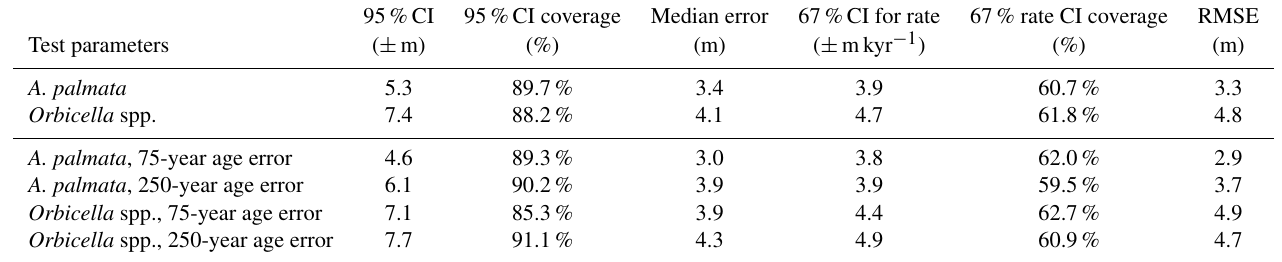
Table D4. Summary of validation test results for the Gaussian model, which are compared to the nonparametric model results (Table D6, select test parameters) with same exact data for sea-level scenario 2 (SL2) to determine the portion of improvement due to the empirical distributions versus due to the inclusion of more data in the nonparametric model. See Fig. 8 for a visual representation of the comparison.